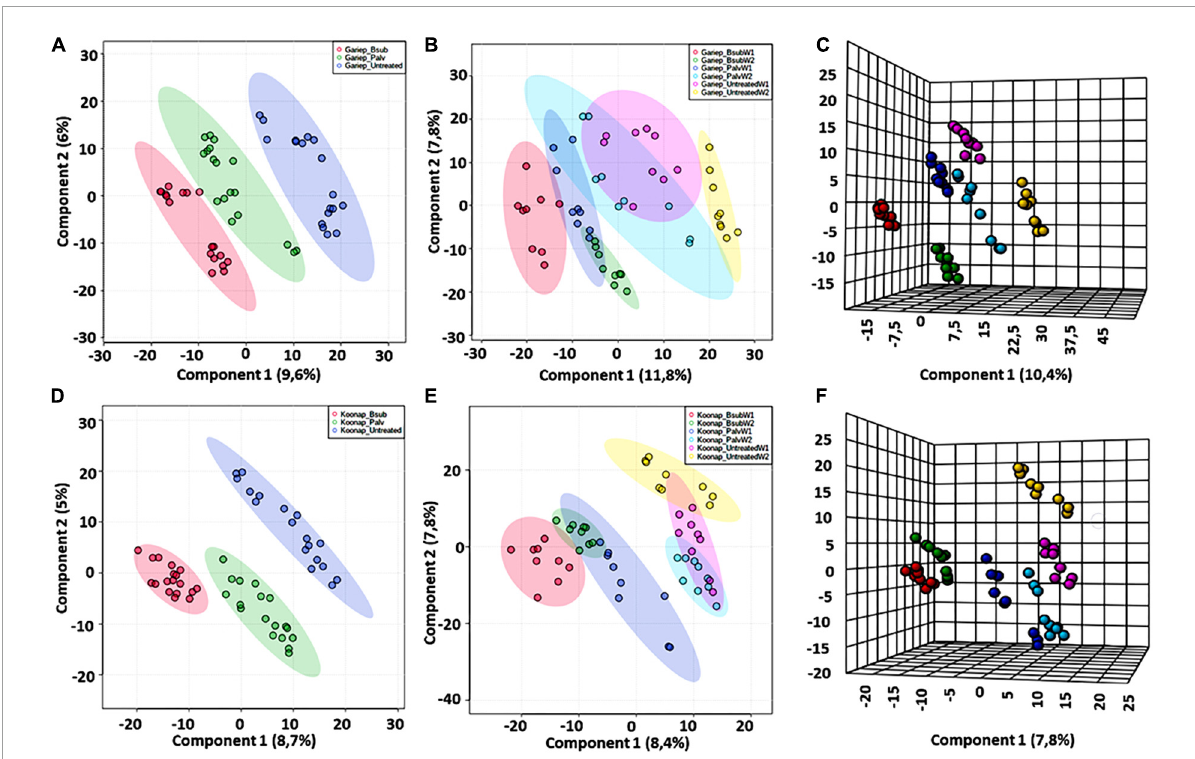
FIGURE2 A supervised partial least square discriminant analysis (PLS-DA) models of plant growth-promoting rhizobacteria (PGPR)-treated and untreated wheat samples. (A) A PLS-DA scores plot showing the global differences in the metabolite profiles from rhizosphere extracts of PGPR-treated (red = Gariep_ B. sub , green = Gariep_ P. alvei ) and untreated (blue) samples. (B) PLS-DA scores plot and corresponding 3D PLS-DA plot. (C) Shows the time-dependent variations and changes in the metabolite profiles of samples in (A) . GBW1 (red)/W2 (green), GPW1 (blue)/W2 (light blue), and GUW1 (purple)/W2 (yellow) represent the B. sub- treated, P. alvei- treated and untreated Gariep rhizosphere soils, respectively. (D) A PLS-DA scores plot showing the separation between plant growth-promoting rhizobacteria (PGPR)-treated (red = B. sub , green = P. alvei ) and untreated (blue) rhizosphere samples of Koonap. The scores plots reveal the differential regulation of the rhizosphere exo-metabolome under varying bacterial treatments and the potential response mechanisms of the different cultivars. (E,F) Shows a 2D and 3D PLS-DA score plots of time-dependent variation in the metabolite profile of the Koonap cultivar from the first and second weeks of extractions respectively, where KBW1(red)/W2(green), KPW1(blue)/W2(light blue) and KUW1(purple)/W2(yellow) represent the B. sub- treated, P. alvei- treated and untreated Koonap rhizosphere soils, respectively. The data projected above were median-normalized, log transformed and Pareto -scaled in MetaboAnalyst for correlation and predictability scores of R 2 = 0.946 and Q 2 = 0.749 (A) ; R 2 = 0.916 and Q 2 = 0.755 (B) , R 2 = 0.984 and Q 2 = 0.815 (C) and R 2 = 0.952 and Q 2 = 0.880; R 2 = 0.928 and Q 2 = 0.695 and R 2 = 0.983 and Q 2 = 0.754, for (D–F) ,